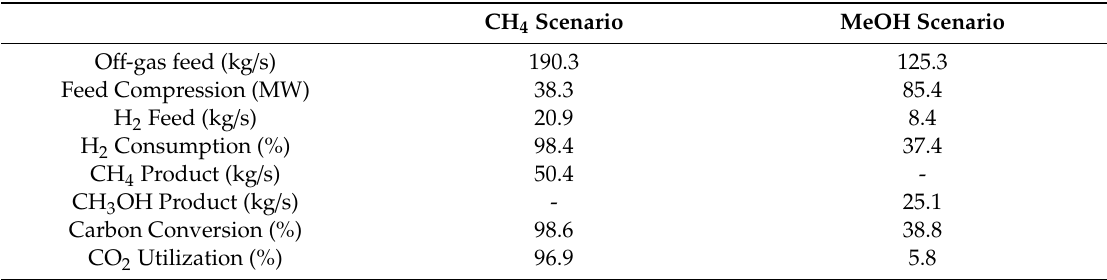
Table 7. Main results of the analyzed